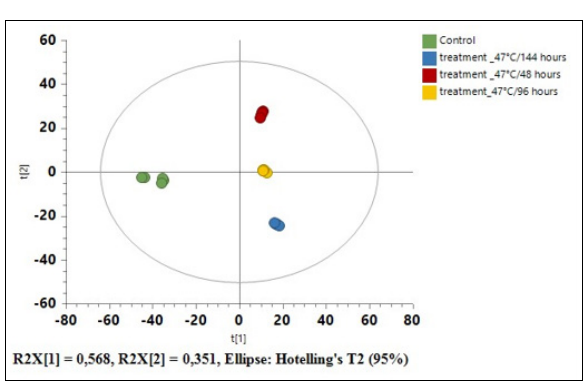
Figure 3: Principal component analysis (PCA) scores scatter plot of Lippia javanica exposed to 25 °C (control) and 47 °C (for 48, 96 and 144 hours).